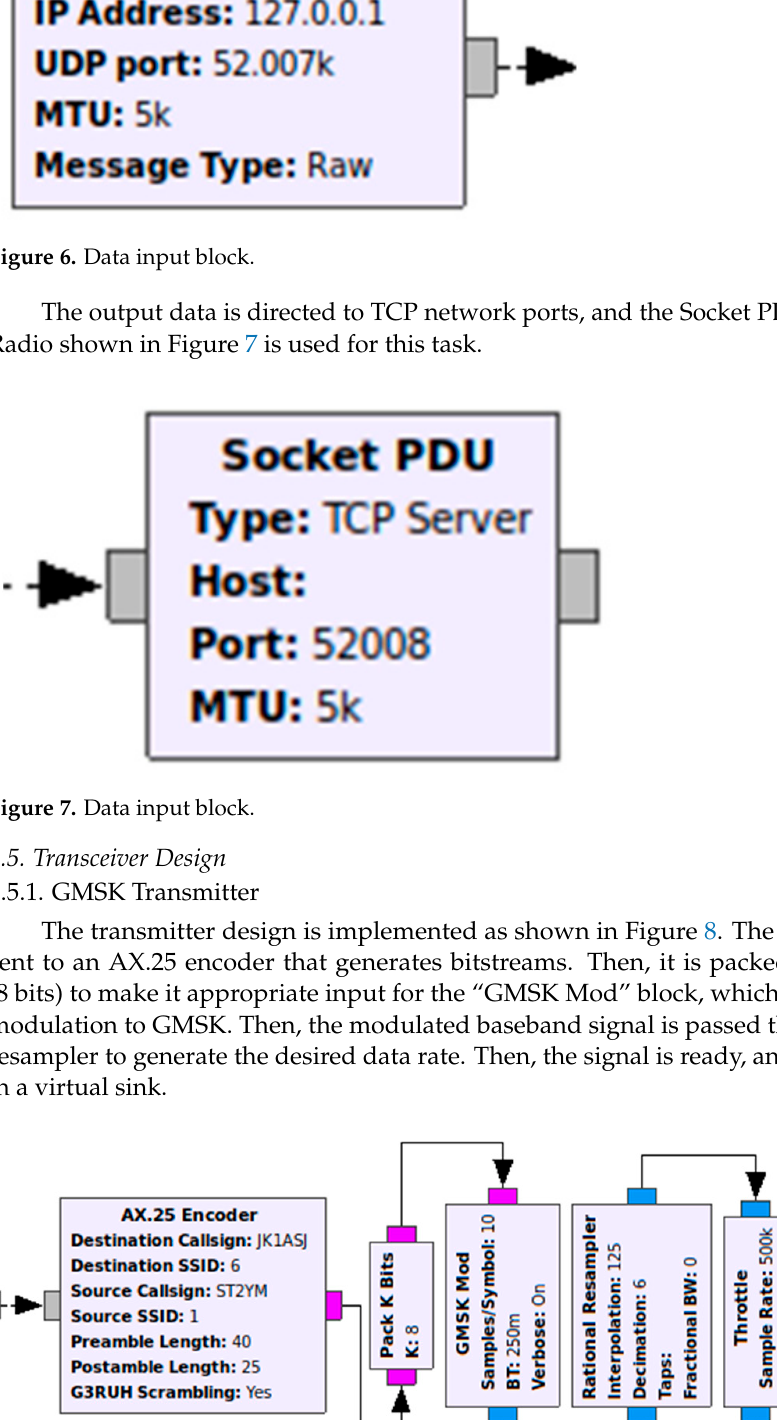
Figure 8. GMSK Transmitter Design in GNU Radio.